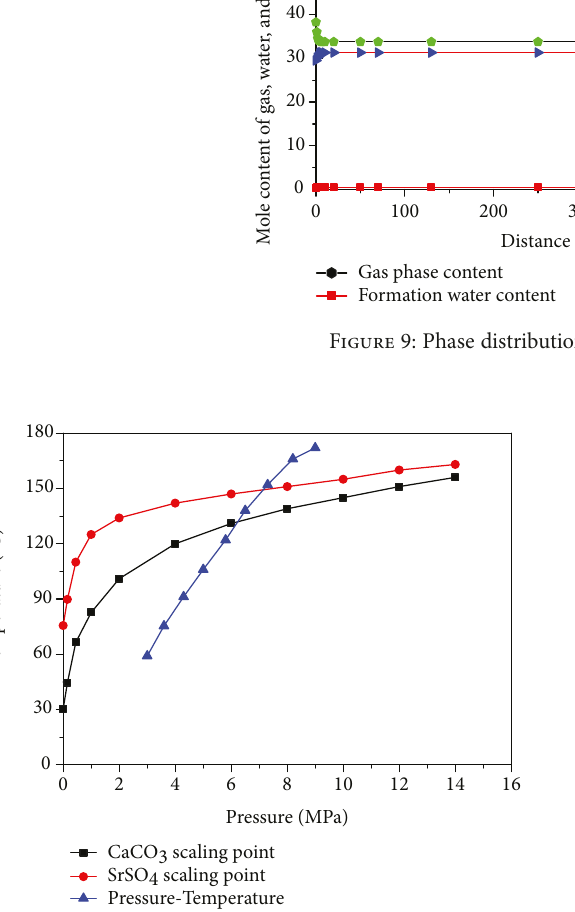
Figure 10: Scaling points of BS8 formation fl